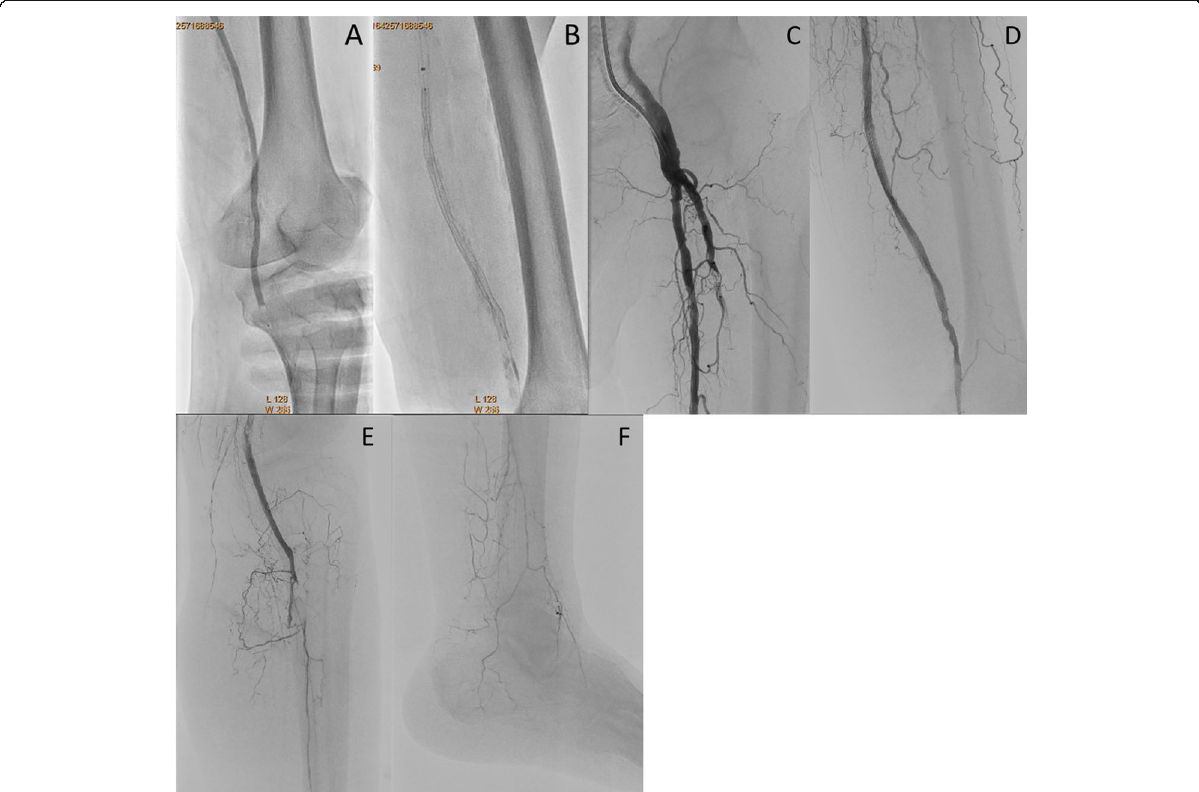
Fig. 4 a : Dilation of a long balloon from the distal superficial femoral artery to the popliteal artery with hemostasis of the retrograde puncture site. b : Deployment of a bare nitinol stent at the site of chronic total occlusion. c : Digital subtraction angiography of the proximal superficial femoral artery. d : Digital subtraction angiography of the middle to distal superficial femoral artery. e : Digital subtraction angiography of the proximal popliteal artery. e : Digital subtraction angiography of the bellow the ankle